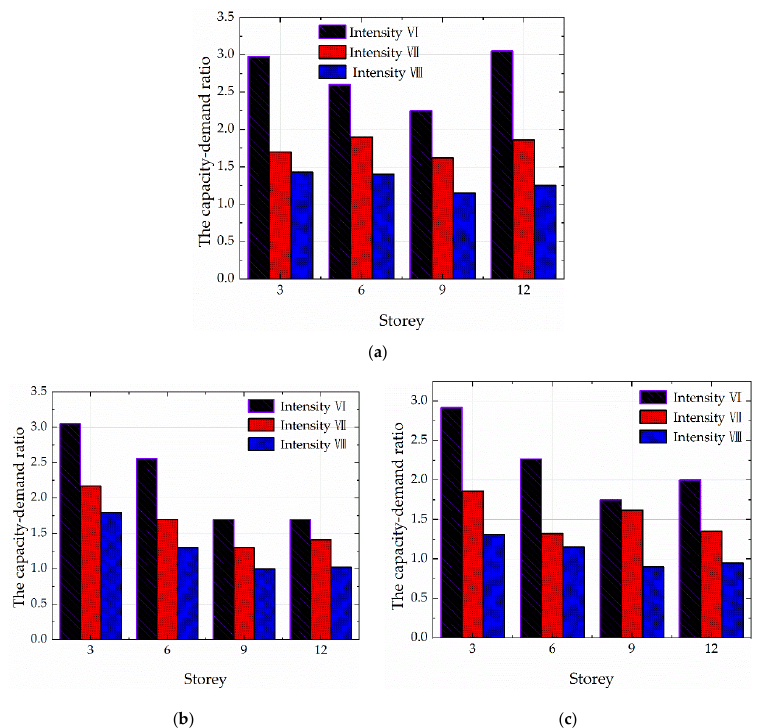
shown in Figure 12.